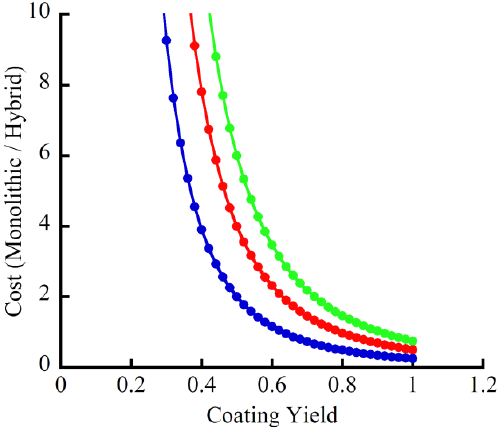
Figure 9. Effect of coating yield on the relative cost of monolithic versus hybrid integrated systems. The graph is simply a plot of a/x3, where x is the coating yield (assumed for simplicity to be the same for all three coating steps) and a is the ratio in part cost between the monolithic chip and the three hybrid chips. The general trends shown will hold true as the analysis is extended to include the cost of the individual coating steps, the packaging, and more realistic ratios in part cost. The blue, red and green tracings represent a values of 0.25, 0.5 and 0.75,